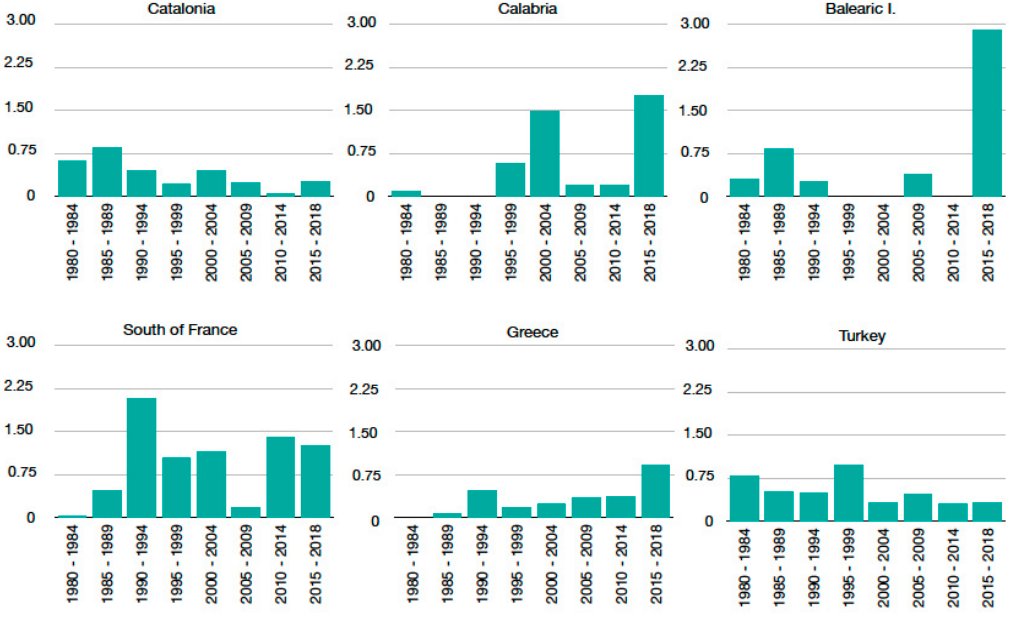
Figure 19. Five-year time step evolution of F per MEFF v2.0 DB regions.